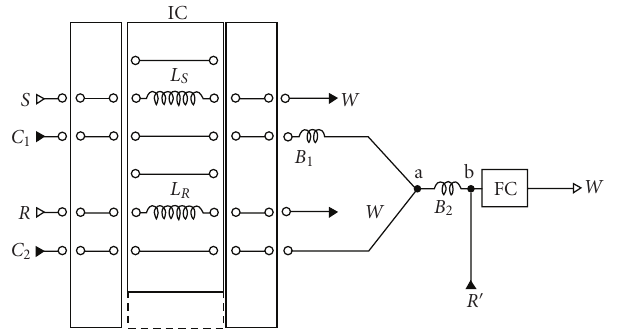
Figure 2: Flow diagram used. S , sample (standard solutions or samples), C 1 and C 2 , carrier streams (phosphate bu ff er solution), R , reagent stream (ferricyanide solution), IC, injector, L S and L R , sample and reagent loops, W , waste, B 1 and B 2 , coiled reactors, a and b, confluent points, R (cid:3) , confluent stream (EDTA solution), FC, flow cell (model FC 2 ), and W , waste. The boxed part relates to the movable bar of the commutator, the dashed lines indicating the next commutating state. The sites where pumping is applied are indicated by arrows. For system dimensioning, see text.